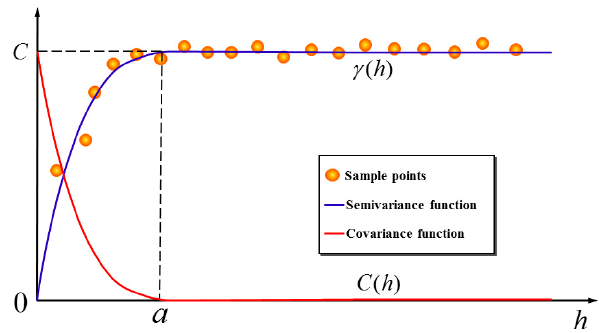
Figure 4. Relationship between semivariance function and covariance function.